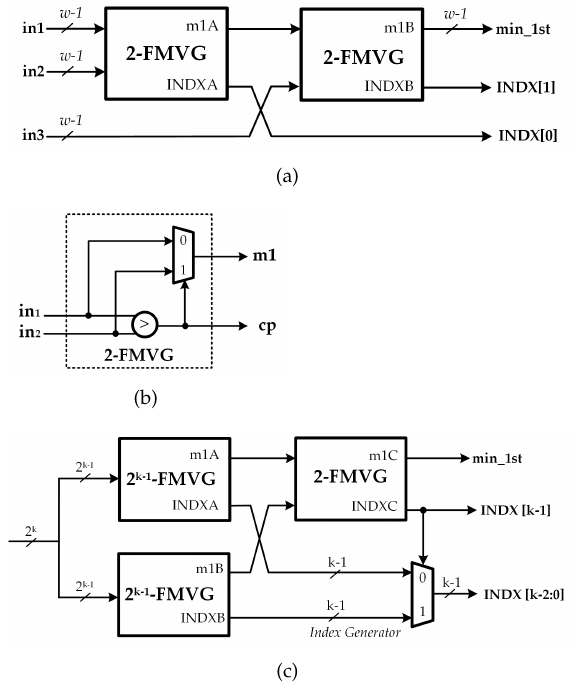
Figure 8. Architecture of 2 k -first minimum value generator (FMVG) unit using the TS approach [34].